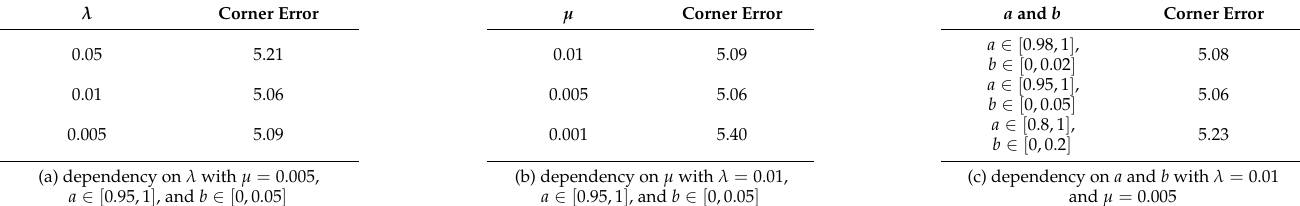
Table A1. Dependency on λ , µ , and a and b . We demonstrate the corner error for different values of parameters using a synthetic benchmark